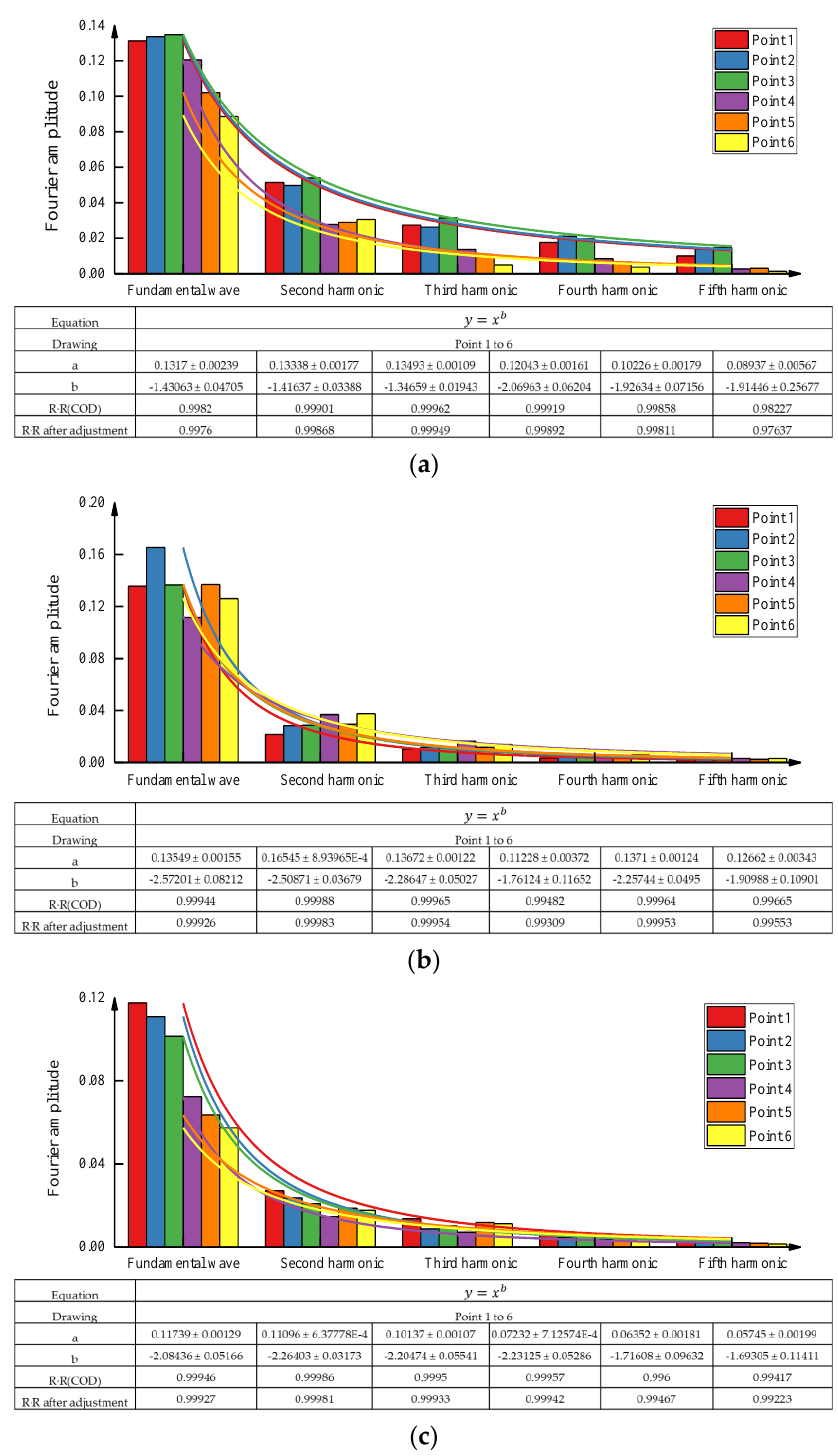
Figure 12. Amplitudes of fundamental and harmonic at different vibratory roller speeds. ( a ) The speed of the vibrated roller is 1.5 km/h. ( b ) The speed of the vibrated roller is 3 km/h. ( c ) The speed of the vibratory roller is 4.5 km/h.